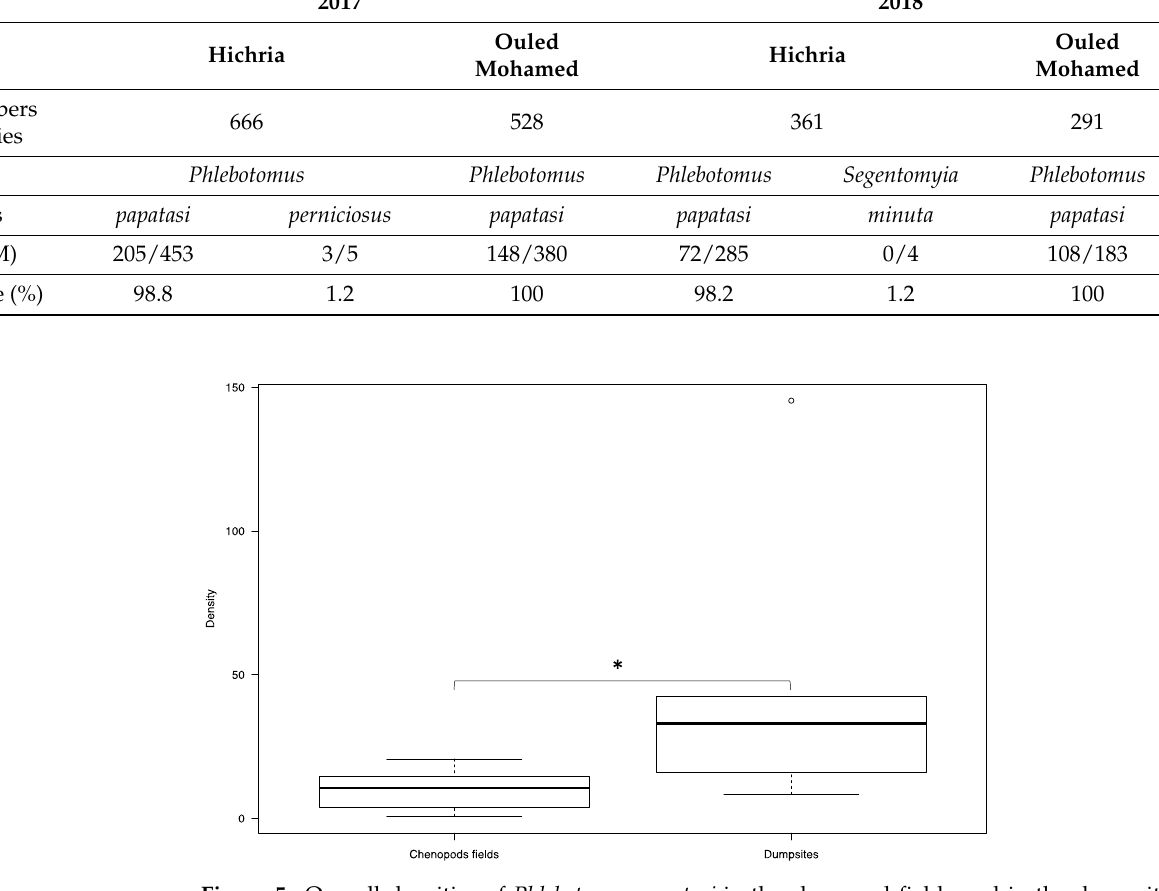
Figure 5. Overall densities of Phlebotomus papatasi in the chenopod fields and in the dumpsites adjacent to the village of Hichria. (The thick black line represents the median. Lower and upper lines represent the first and third quartile, respectively. Whiskers show the minimum and maximum values. Outliers are represented by circles. Significance: * < 0.05.